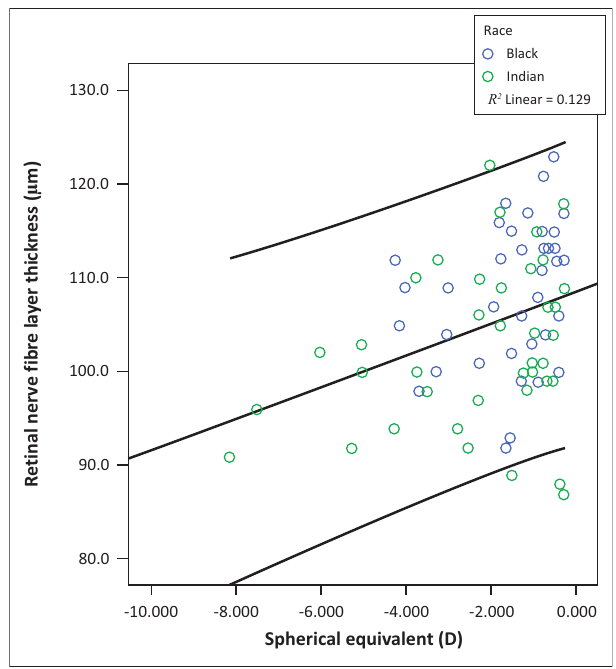
FIGURE 2: Scatter plot showing the relationship of spherical equivalent and global retinal nerve fibre layer thickness (for the total sample) with 95 % confidence interval of the regression line ( R 2 = 0.13, r = 0.36, p =